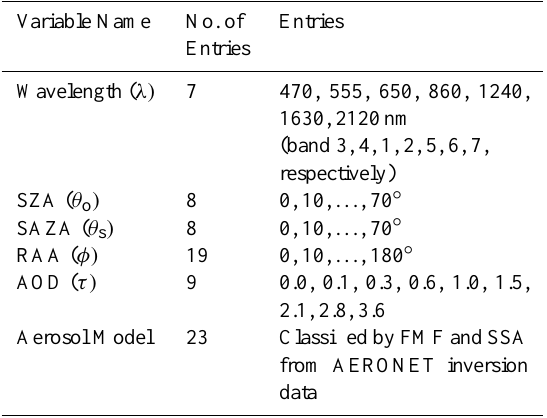
Table 1. LUT dimensions for the MODIS over-ocean